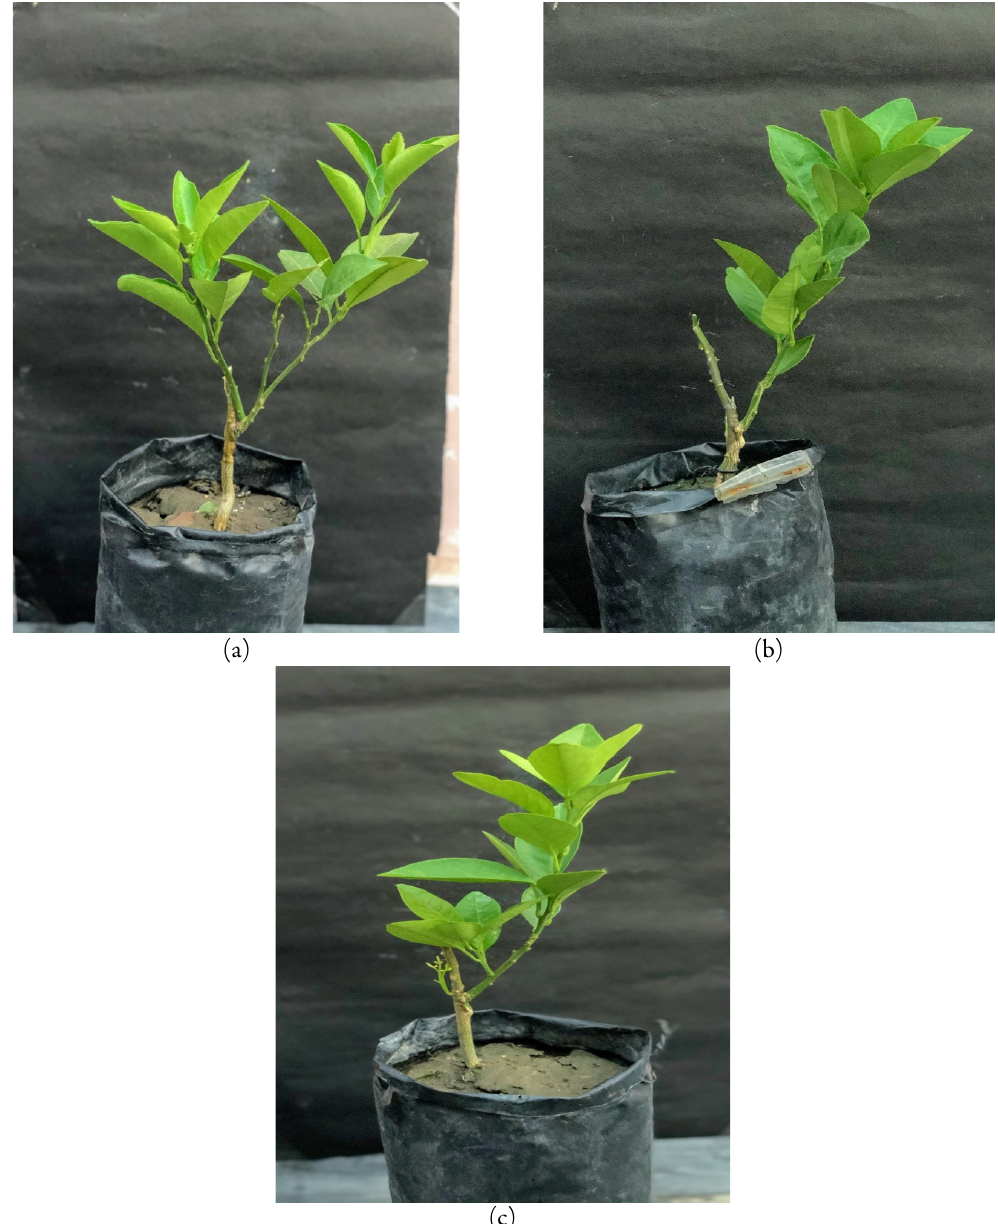
Figure 3. Survival of plants budded during first week of September at 120 days after budding in sweet orange cultivar (a) ‘Blood Red’ (b) ‘Jaffa’ (c) ‘Valencia